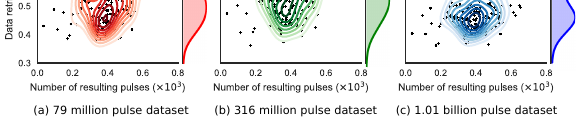
Figure 9. Data retrieval from HBase for small queries